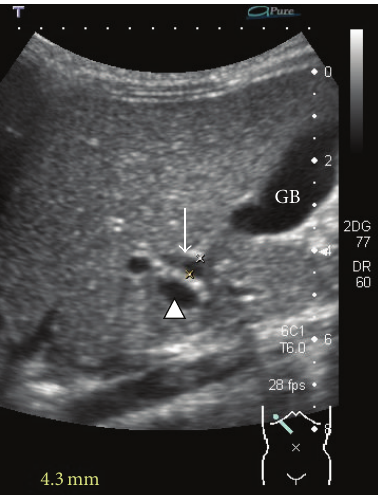
Figure 1: Common bile duct dilatation on ultrasound (arrow). The duct is measured as 4.3 mm. Portal vein (arrowhead). GB: